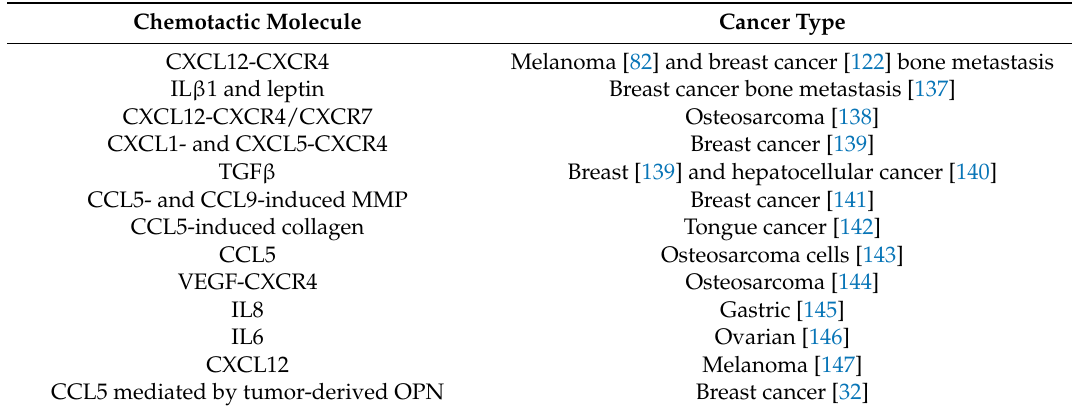
Table 1. Stromal-derived chemoattractants mediating tumor cell